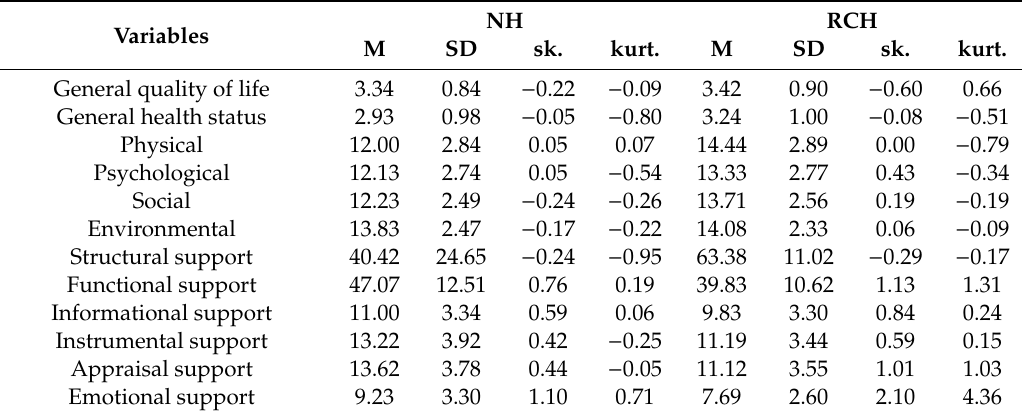
Table 1. Basic descriptive statistics.